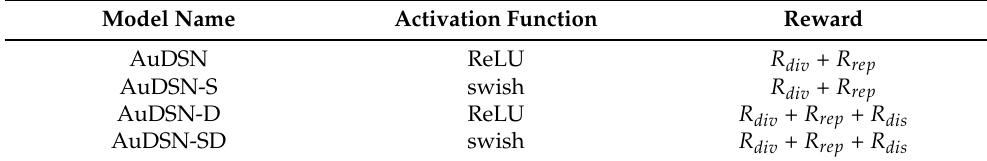
Table 1. Definitions of different